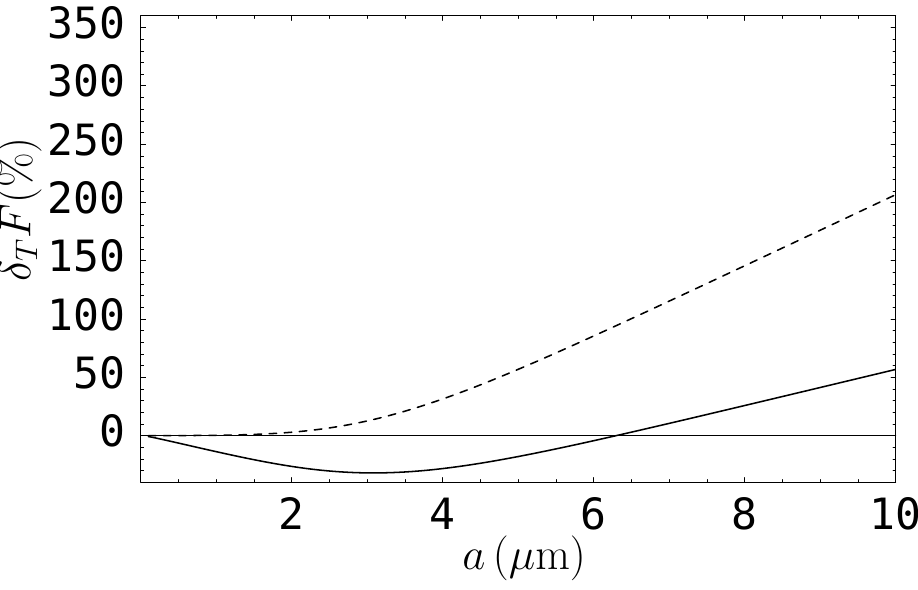
Figure 1. The relative thermal corrections for the Casimir force between gold plates computed in the framework of the Lifshitz theory at T = 300 K using the Drude and the plasma models are shown as functions of separation by solid and dashed lines,